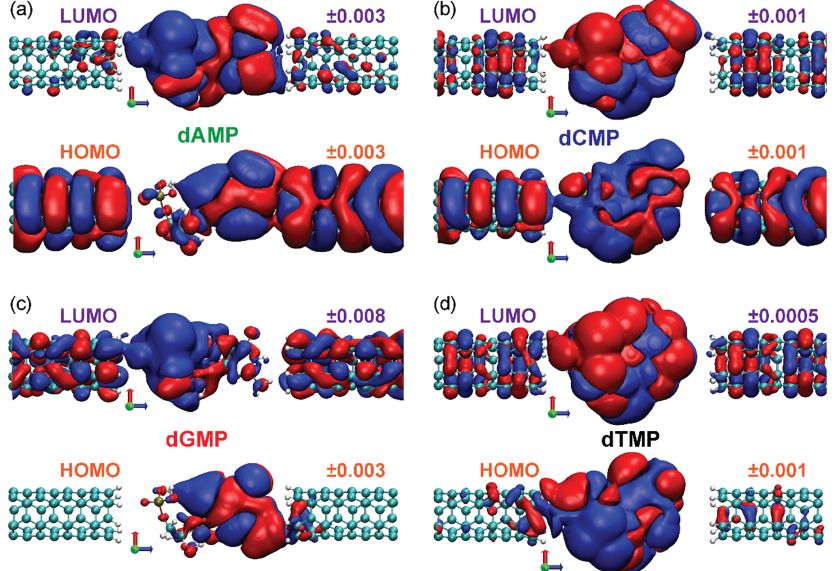
Figure 4. The isosurfaces of MPSH frontier orbital wave functions ψ HOMO/LUMO calculated at zero bias for ( a ) dAMP, ( b ) dCMP, ( c ) dGMP, and ( d ) dTMP between two H-terminated CNTs. The indication of MPSH orbital (HOMO and LUMO) is above the left, with the positive (red surface) and the negative (blue surface) isovalues above the right CNTs. Red, green, and blue arrows indicate x , y , and z axes, respectively.